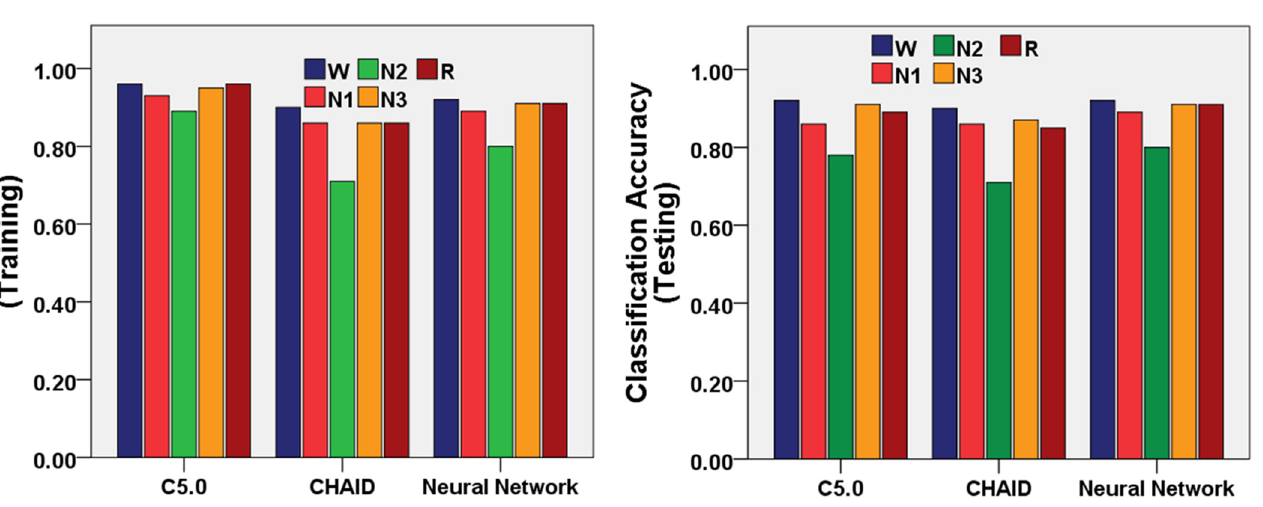
Figure 4. Performance of the three machine-learning models (C5.0, Neural Network, and CHAID Models) to classify the sleep stages W, N1, N2, N-3, and R using training and testing datasets of